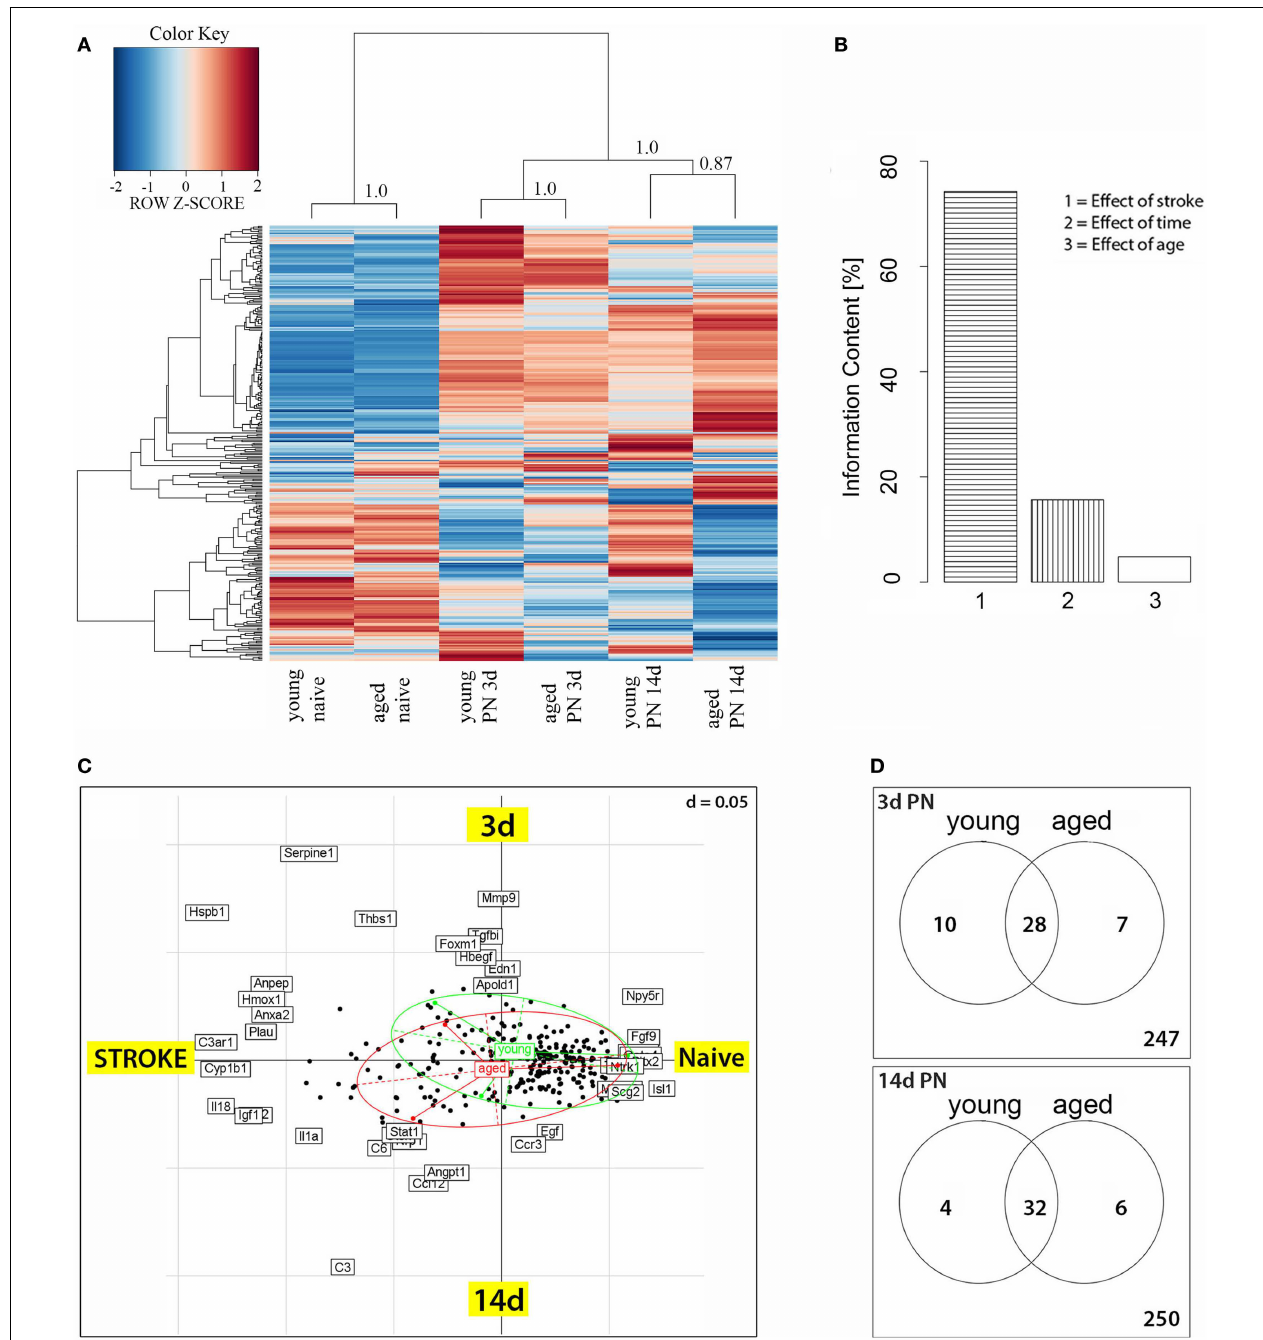
correspondence analysis and shows that the major factors contributing to the variance of stroketomics analysis were stroke (75%), post-stroke time (15%), and age (10%). (C) Sources of variability were stroke and post-stroke time, which formed the coordinates.The graph shows the distribution of transcripts (black dotes) as a function of treatment (stroke) and post-stroke time. Samples from young (green ellipse) and aged (red ellipse) animals show an extensive overlap as well as some difference in their post-stroke response. (D) Venn diagrams for 3 and 14days post-stroke penumbra (PN) showing genes that were up- or downregulated exclusively in old or young rats, or in both age